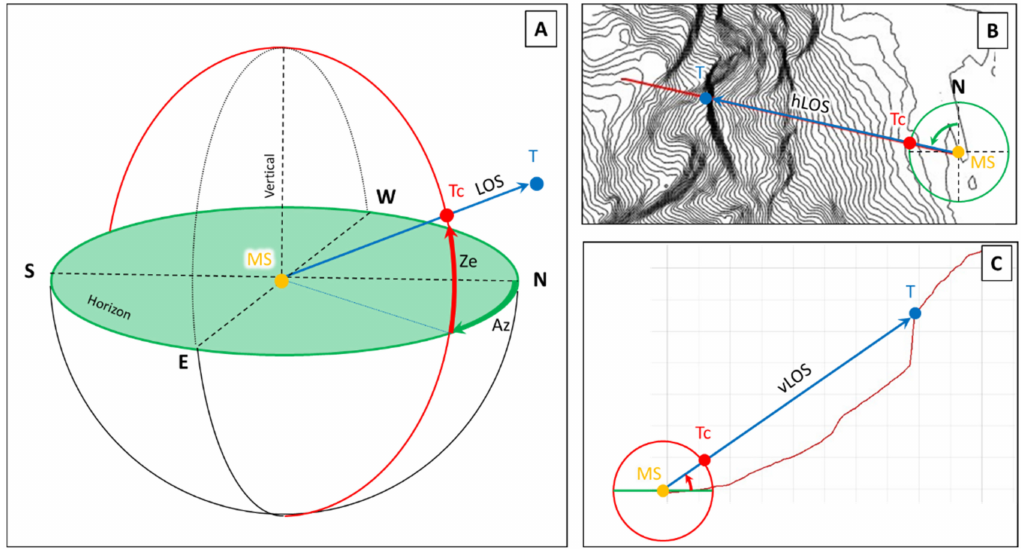
Figure 2. CoordFinder schematized working principle where ( A ) is the Pseudo 3D view, ( B ) the Map view, and ( C ) the Profile view. The green plane is the horizontal and the red circle is the vertical plane. (MS) Measuring Station, (T) Target sighted, (LOS) Line Of Sight, (Tc) Target projection on the vertical circle, (Ze) Zenithal angle, (Az) Azimuthal